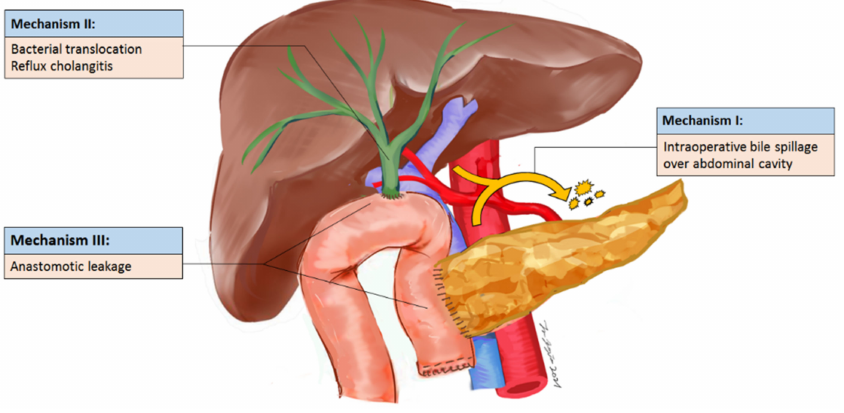
Figure 3. Potential mechanism of intra-abdominal